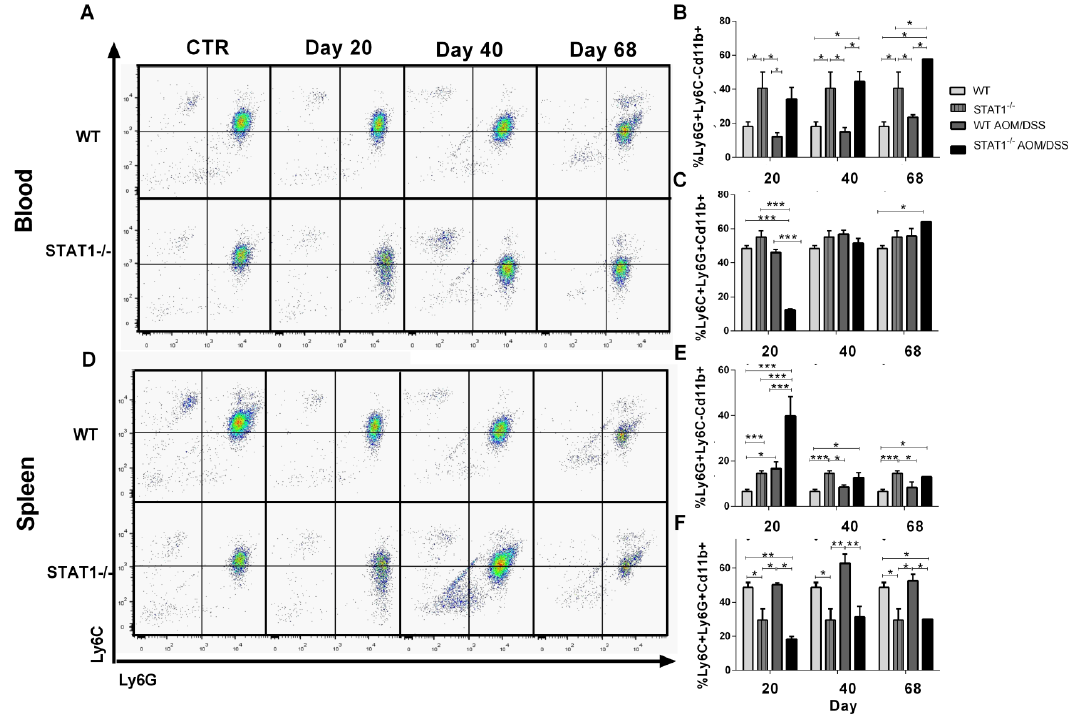
Figure 7. Increase of Ly6G + Ly6C − Cd11b + cells in STAT1 − / − mice during CAC development. Circulating and spleen cells were obtained from WT or STAT1 − / − AOM/DSS-treated or control mice at the indicated time intervals and were analyzed for expression of Ly6C and Ly6G on living CD11b + population cells by flow cytometry. ( A ) Representative dot plots in total blood. ( B ) Frequencies of Ly6G + Ly6C − CD11b + cells and ( C ) Ly6C + Ly6G + CD11b + cells in the blood of WT or STAT1 − / − AOM/DSS-treated or control mice, gated as in ( A ). ( D ) Representative dot plots in splenocytes. Frequencies of ( E ) Ly6G + Ly6C − CD11b + cells and ( F ) Ly6C + Ly6G + CD11b + cells in the splenocytes of WT or STAT1 − / −